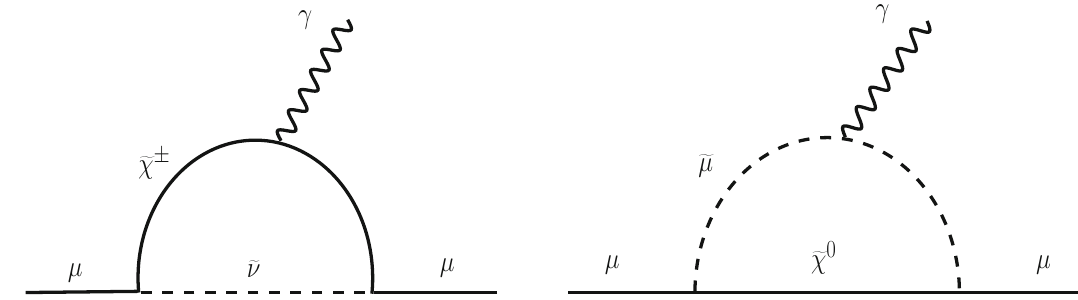
Fig. 1 Chargino-sneutrino (left) and neutralino-smuon (right) one-loop contributions to the anomalous magnetic moment of the